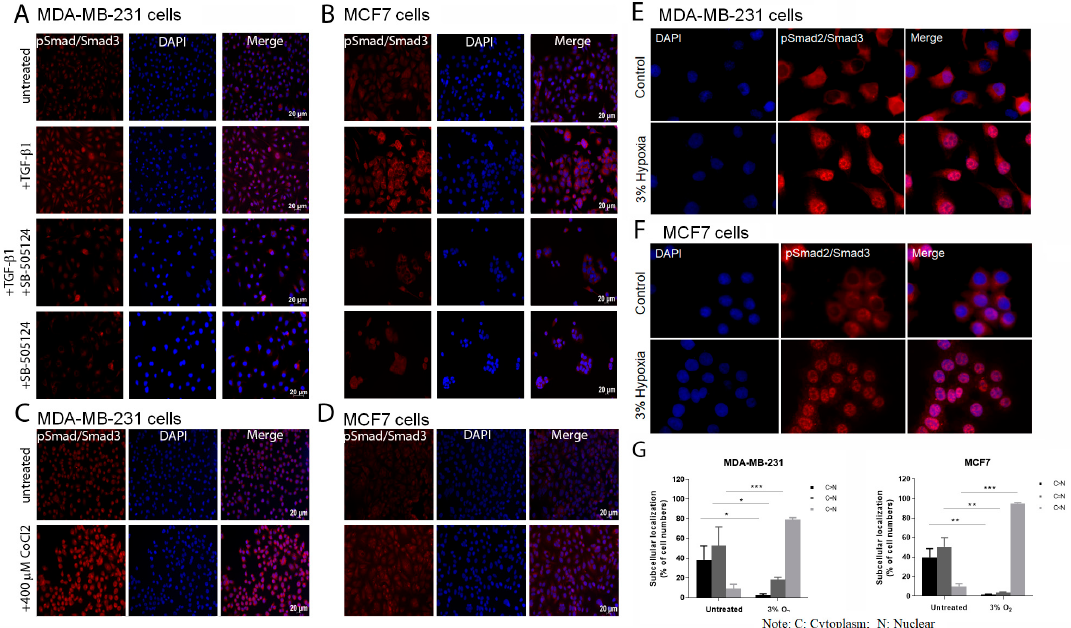
Figure 1. Immunocytochemical (ICC) analysis for pSmad2/3 expression following treatment with TGF- β 1 or CoCl2 in both MDA-MB-231 and MCF7 cell lines. Increased expression of pSmad demon- strates activation of the TGF- β signalling pathway in both breast cancer cell lines upon treatment with 5 and 10 ng/mL TGF- β 1, respectively, for 72 h compared to controls and untreated cells. Note the addition of 5 μ M of SB-505124 in the presence or absence of TGF- β 1 results in decreased pSmad expression in both cell lines ( A ) MDA-MB-231 ( B ) MCF7 cells. ICC images for pSmad2/3 staining showing activation of the TGF- β signalling pathway induced via exposure to 400 μΜ CoCl 2 for 48 h in ( C ) MDA-MB-231 and ( D ) MCF7 cells or culture in 3% oxygen for 48 h in ( E ) MDA-MB-231 and ( F ) MCF7 cells. ( G ) Graphical representation of the proportion of cells showing either cytoplasmic (C) or nuclear (N) localization after hypoxia exposure; C < N, C = N, C > N. Note increased pSmad staining after treatment compared to that in negative control and untreated cells. Representative images from n = 3 experiments. Scale bar = 20 μ m, pSmad expression = red, nuclei were stained with Dapi = blue. ( E , F ) Original magnification 40×. p values * p value < 0.05, ** p value < 0.005, *** p value ≤ 0.001. To determine if CoCl 2 exposure can also activate the TGF- β signalling pathway, the levels of pSmad2/3 protein levels in unfractionated MDA-MB-231 and MCF7 cells un- treated and treated with 400 μΜ CoCl 2 for 48 h were assessed. Treatment resulted in an increase in pSmad2/3 levels in both cell lines (Figure 1C,D). Cells of both cell lines were also incubated in a hypoxic environment (3% oxygen for 24 h) and assessed for pSmad2/3 and again treatment resulted in an increase in pSmad2/3 levels (Figure 1E,F). In addition, after culture in 3% oxygen, both cell lines showed a greater proportion of cells with nuclear staining for pSmad2/3 (Figure 1G). 3.2. Assessment of TGF- β Receptor Expression and Endogenous TGF- β 1 Production in MDA-MB-231 and MCF7 Cells q-PCR analysis was used to measure mRNA expression of TGF- β 1, TGFB-RI and TGFB-RII. There was no significant difference in expression of TGFB-R1 between the two cell lines (Figure 2A), while levels of TGF- β 1 and TGFB-RII were significantly higher in the MDA-MB-231 than in the MCF7 cells ( p = 0.04) (Figure 2A). In addition, endogenous expression of TGF- β 1, TGFB-R1 and TGFB-RII protein was determined using Western blotting for both cell lines. Both cell lines expressed TGF- β 1 and both receptors, with ex- pression in all cases being lower in the MCF7 than the MDA-MB-231 (Figure 2B). Images of whole western blots are provided (Supplementary Figure S1).